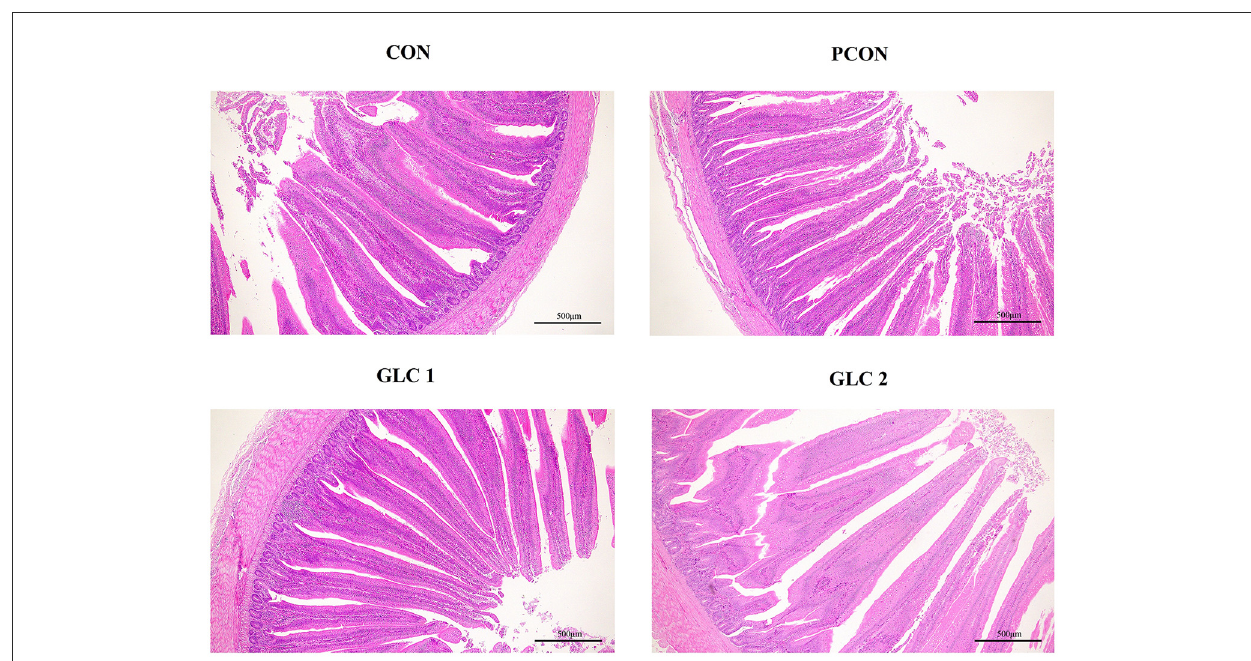
FIGURE1 Effect of Ganoderma lingzhi culture (GLC) supplementation on the ileum morphology of Sanhuang broilers ( n = 6; CON, control diet; PCON, positive control diet; GLC 1: 1.5% GCL diet; GLC 2: 3% GCL